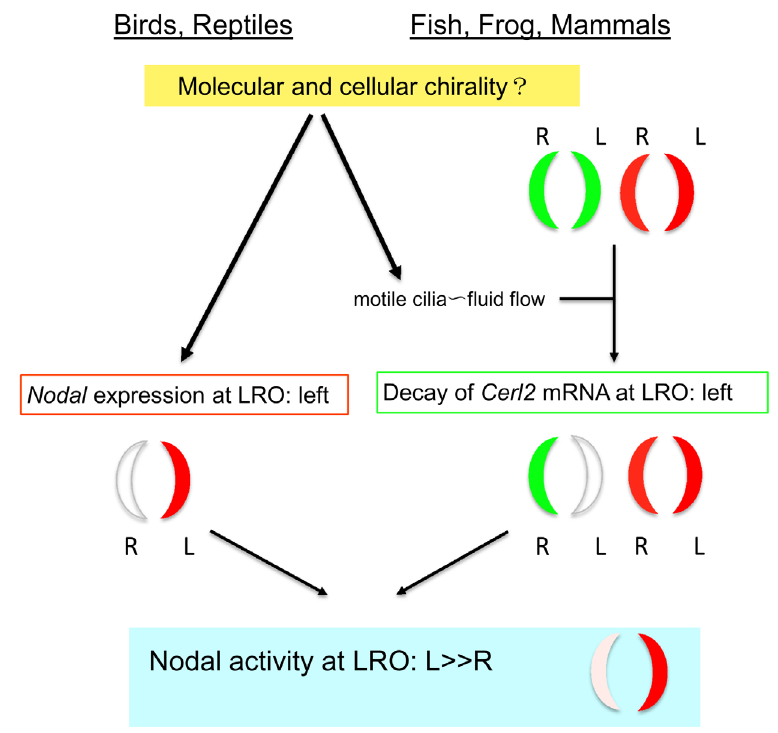
Figure 1. The molecular cascade of cilia dependent and non-dependent mechanisms leading to the asymmetric Nodal activity in the left-right organizer (LRO) of the vertebrate embryos. Nodal activity (red), Cerl2 activity (green). Note that both mechanisms result in asymmetric (L>R) Nodal activity at the